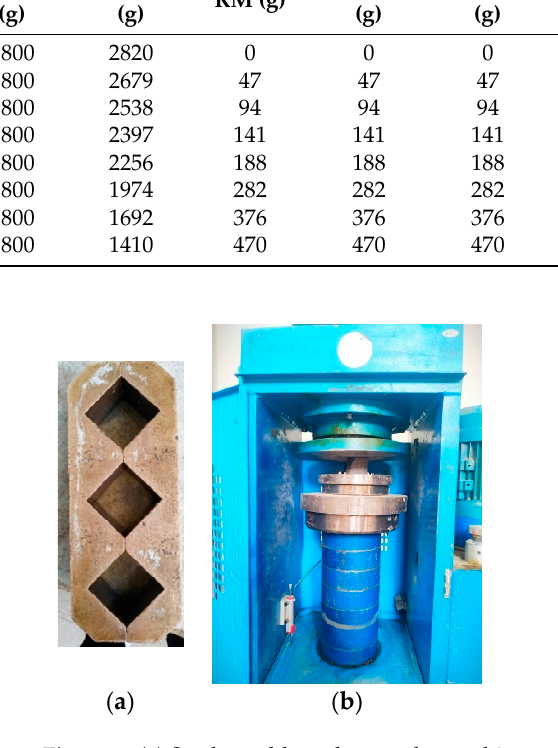
Figure 6. ( a ) Steel mould used to produce cubic samples; ( b ) the strength-testing machine. Table 2. Mix proportions of all mortars and their properties.